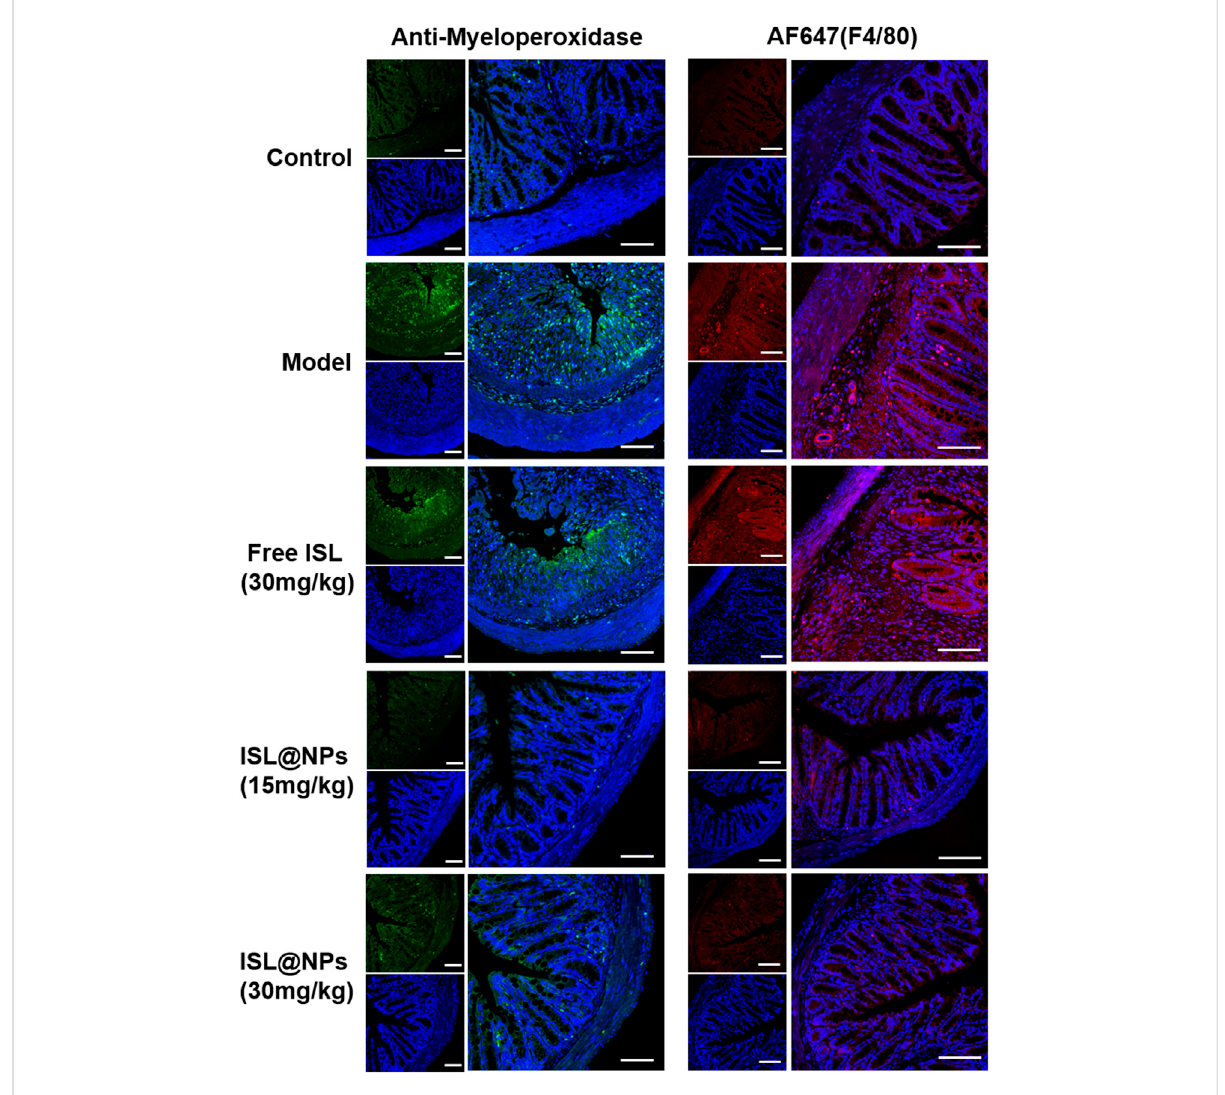
FIGURE 7 Immuno fl uorescence staining of neutrophils and macrophages in colon tissues of mice from different groups. The blue, green, and red fl uorescence derived from the stained nuclei, neutrophils, and macrophages, respectively. Scale bar = 100 μ m.